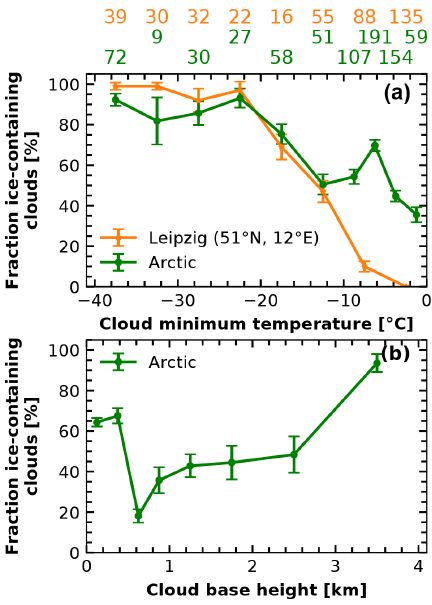
Figure 4. (a) Fraction of ice-containing clouds as a function of min- imum cloud temperature within the heterogeneous ice nucleation regime. Data of all clouds of the Arctic 2017 field campaign are plotted in green. In orange the results for Leipzig from Fig. 3 in Kanitz et al. (2011) are shown. The error bars indicate the statis- tical uncertainty as in Seifert et al. (2010). Temperature intervals increase with decreasing minimum cloud temperature due to de- creased number of data ( (cid:49)T = 2 . 5 ◦ C above − 10 and 5 ◦ C below − 10 ◦ C). The numbers on top of the plot show the number of data for each temperature interval, and the data points have been placed in the middle of the respective investigated interval. (b) Fraction of ice-containing clouds for different liquid layer base height inter- vals. Base height intervals increase with increasing liquid layer base height due to decreased number of data ( (cid:49)h = 0 . 25km below 1km, 0.5km between 1 and 2km, and 1km above